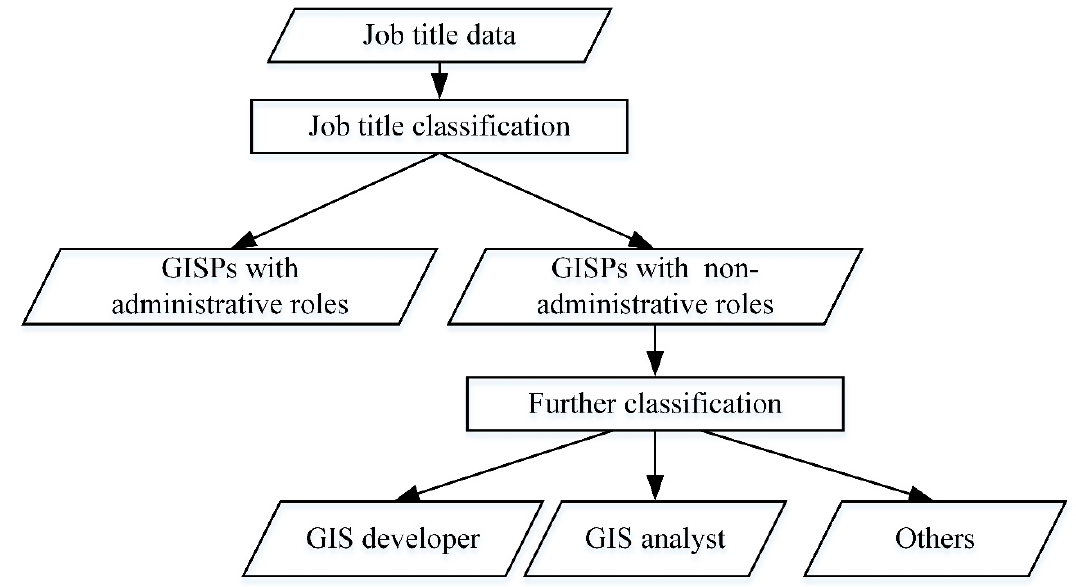
Figure 1. The flowchart of job title analysis.